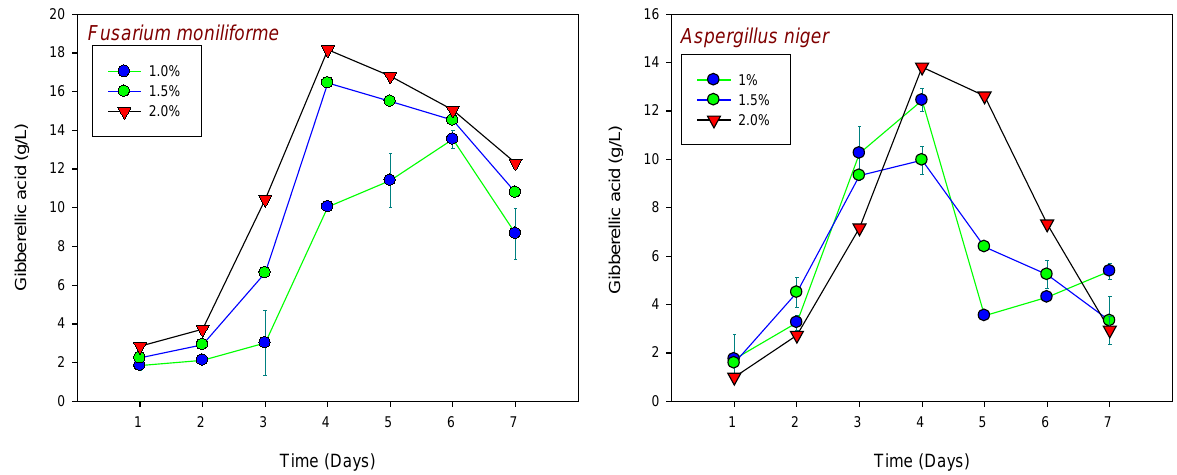
Fig. 3. Effect of varying inoculum size on gibberellic acid yield using F. moniliforme and A. niger grown on banana peel as